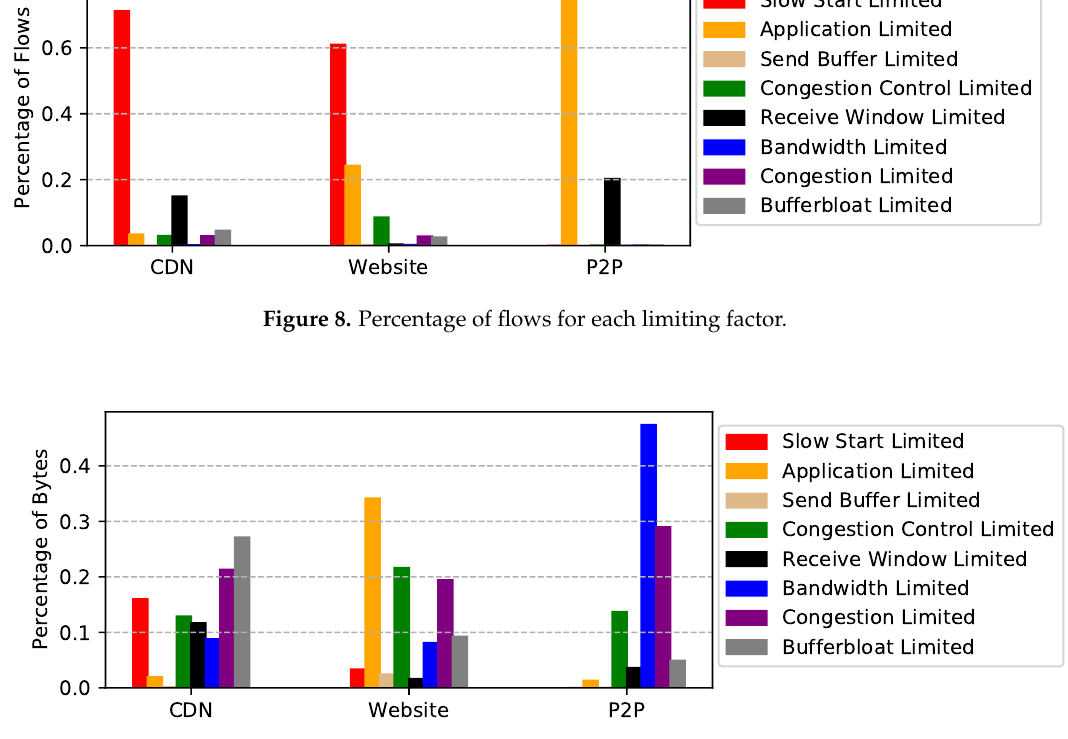
Figure 9. Percentage of bytes for each limiting